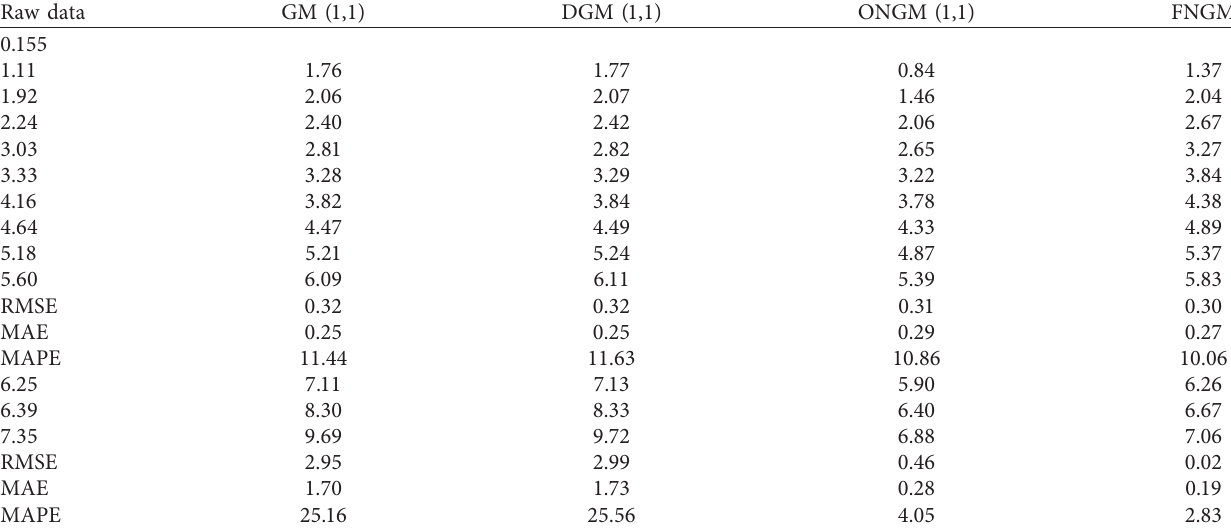
Table 2: Fitted values and statistical indices by different grey models.